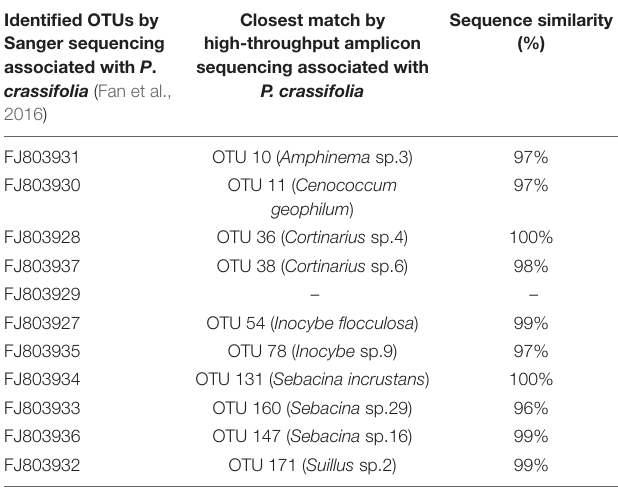
TABLE 4 | The similarity of OTU sequences between the Sanger sequencing and high-throughput amplicon sequencing associated with P. crassifolia . Identified OTUs by Closest match by Sanger sequencing high-throughput amplicon associated with P . sequencing associated with crassifolia (Fan et al., P. 2016)